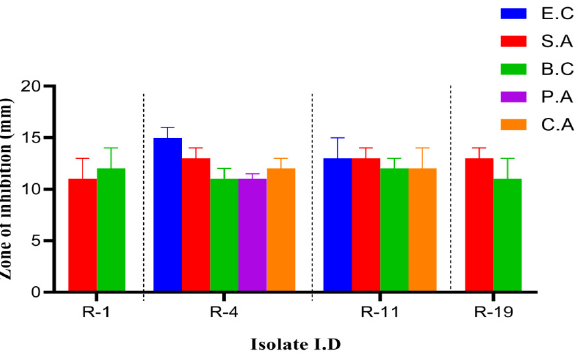
Figure 4. Zones of inhibition of the six active bacterial metabolic crude extracts. E.C.: Escherichia coli , S.A: Staphylococcus aureus , B.C: Bacillus cereus , P.A: Pseudomonas aeruginosa and C.A: Candida albicans .